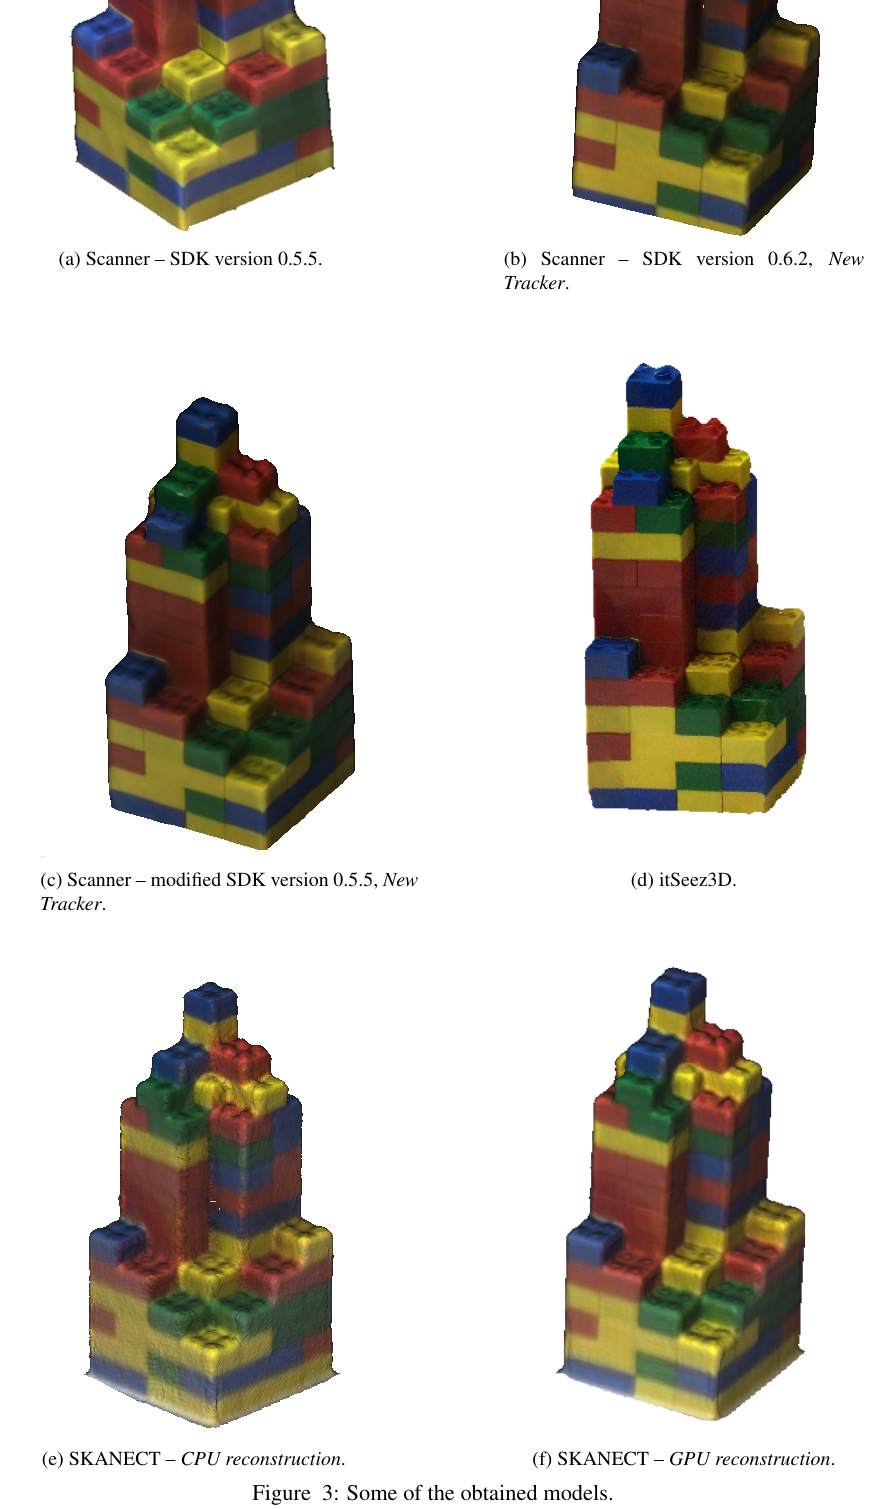
Figure 3: Some of the obtained